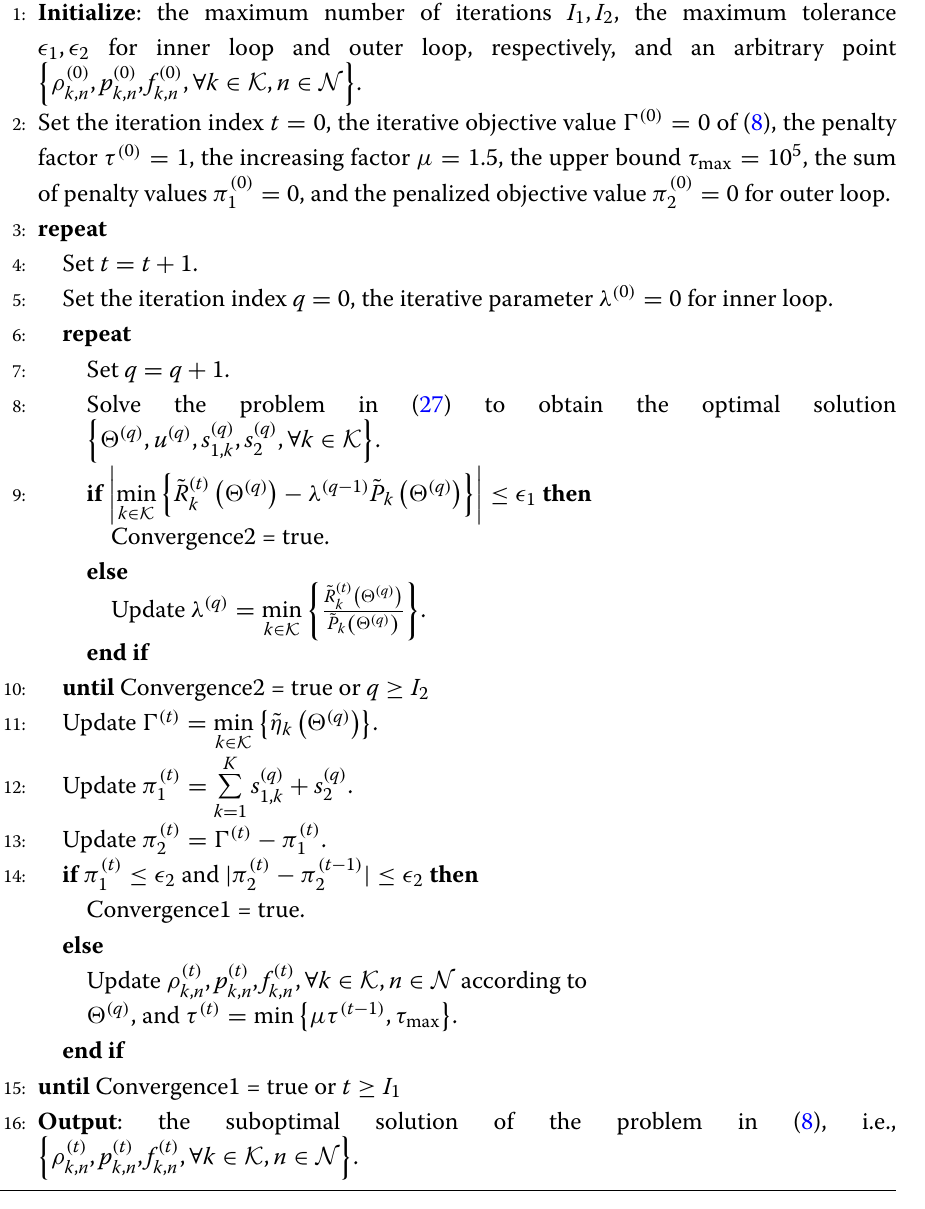
Algorithm 1 Proposed CE Optimization